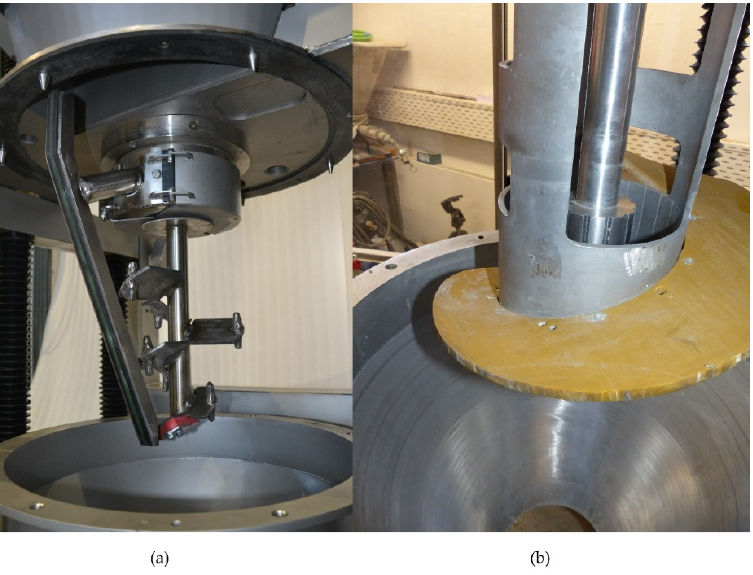
Figure 3. ( a ) Mixing with inner and outer agitator of the KNIELE KKM-RT; ( b ) Coaxial-system with attached spiral for measuring in absolute units; high 170 mm; radius inner cylinder 38 mm and inner radius outer cylinder 85 mm.